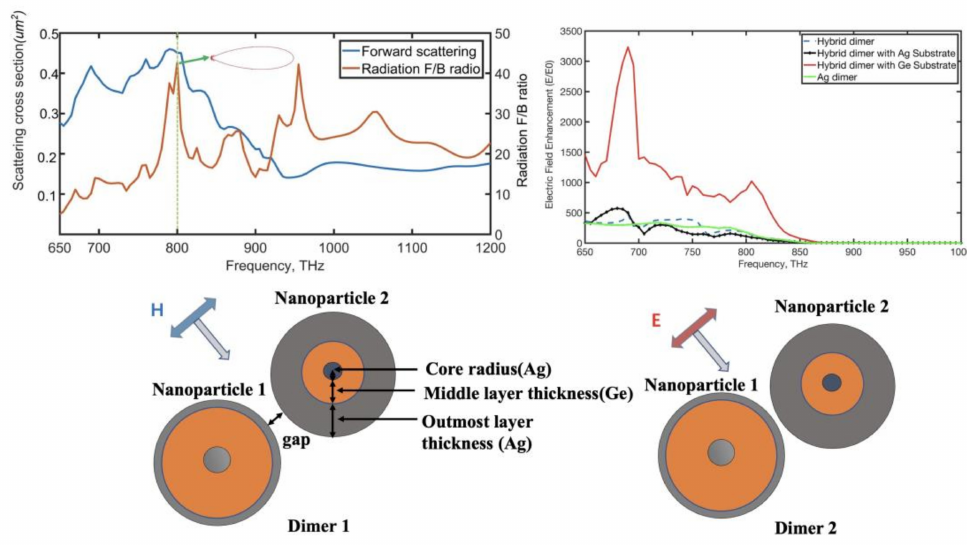
Figure 1. The mechanism of unidirectional forward scattering with narrow radiation beamwidth and strong enhancement of local electric field in the asymmetric metal-dielectric-metal dimer which is excited by incident light with different orientations of electric and magnetic polarization.